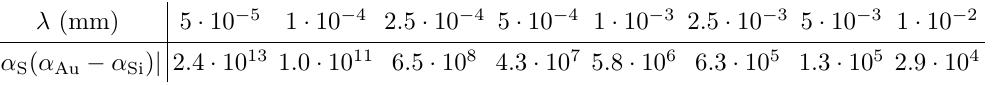
Table 10 . 95% C.L. constraints on the combinations | α W α W | as a function of λ = 1 /m a set by the IUPUI experiment